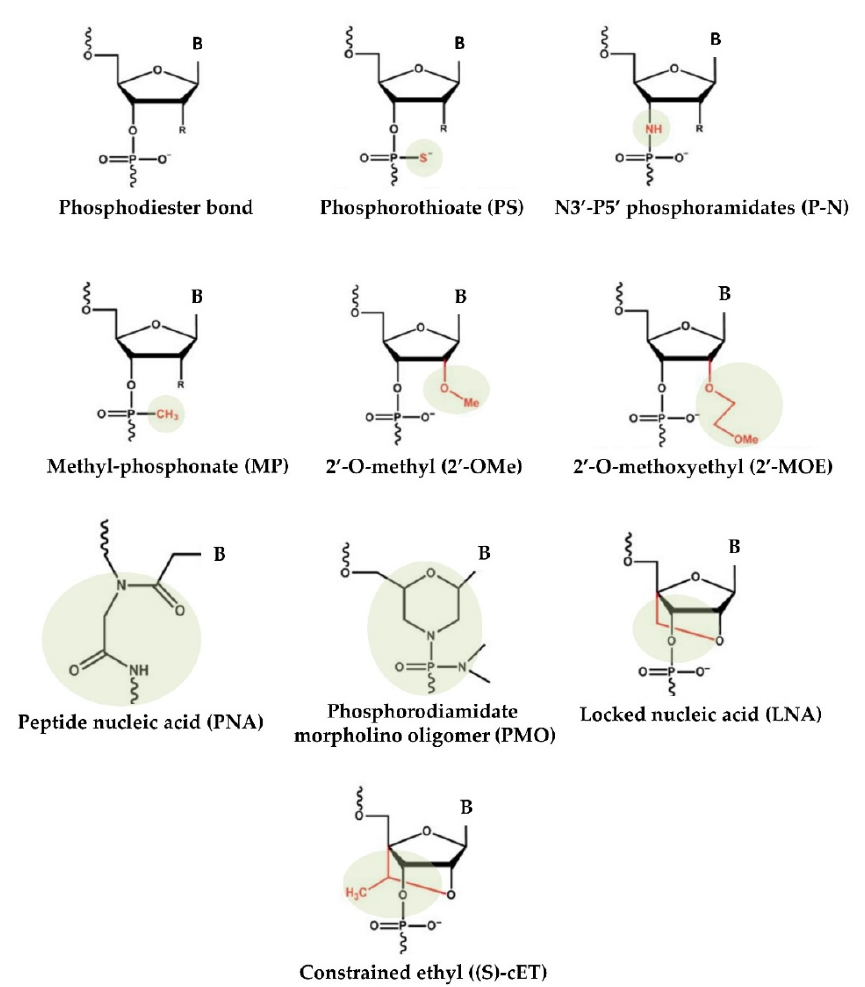
Figure 1. Chemical changes of oligonucleotides used in main clinical trials.